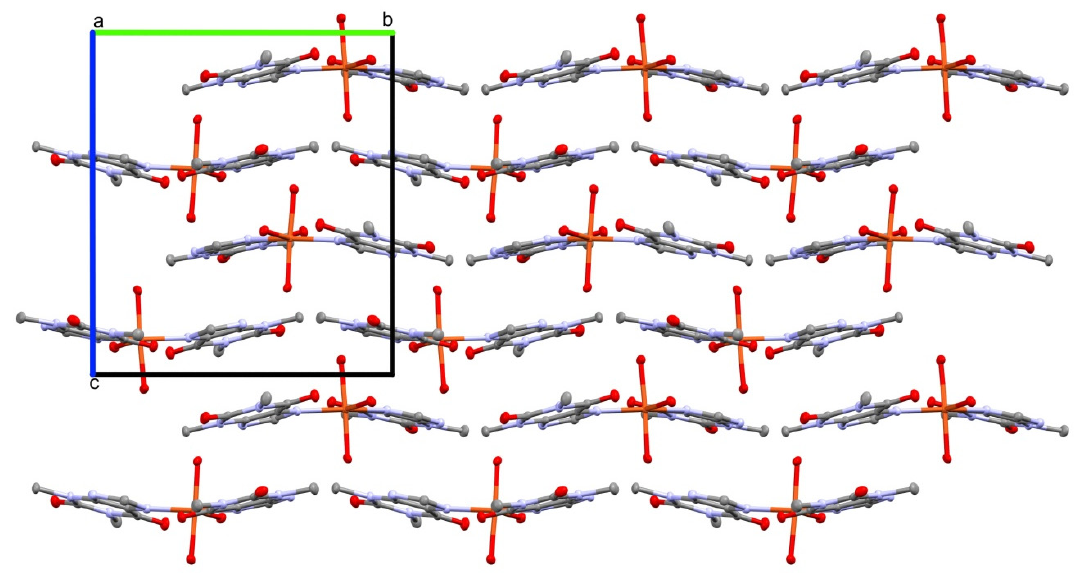
Figure 3. The supramolecular puckered ribbons running along the [010] direction. Crystals axes are indicated by a, b and c symbols.